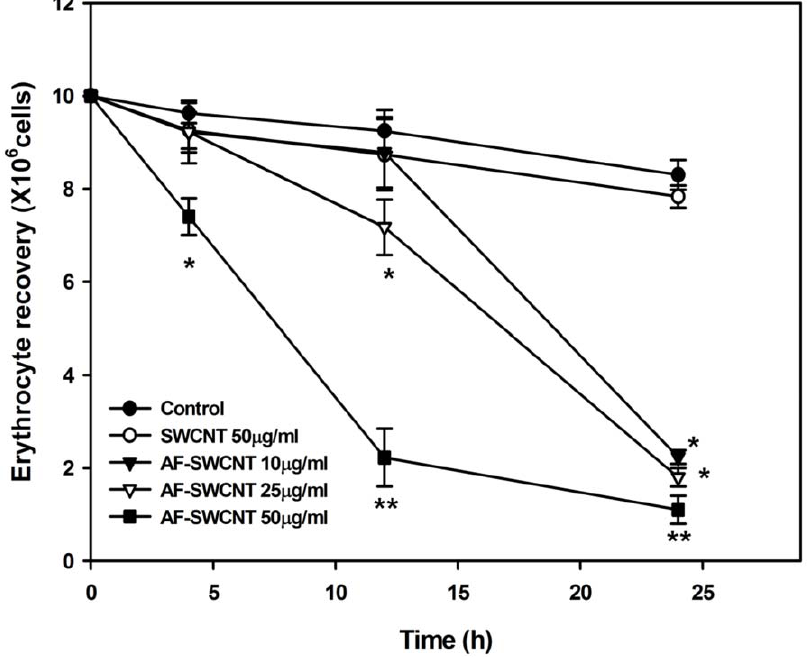
Figure 1. Effect of Control and AF-SWCNT’s on erythrocytes invitro . Erythrocytes isolated from Swiss mice were cultured in RPMI + 10%FBS with different concentrations of control and AF- SWCNT preparations. After different time intervals, residual erythrocyte count was determined. Each point represents Mean 6 SEM. *p , 0.01, **p , 0.001 as compared to control untreated groups.